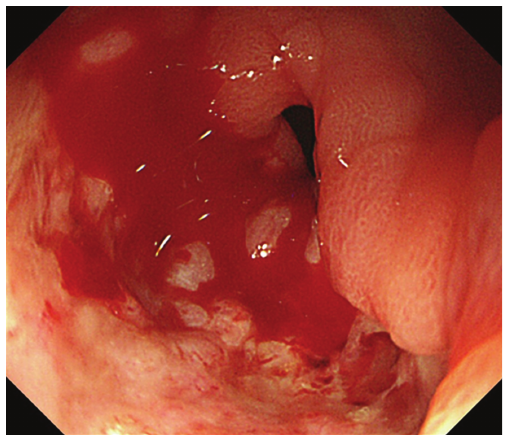
Figure 1: Endoscopic appearance of post-ESD ulcer with active bleeding.